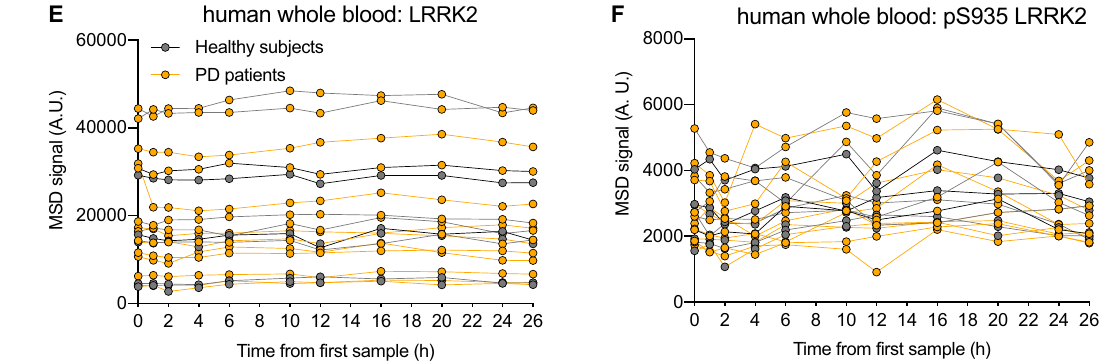
Figure 4. Development of LRRK2 and pT73 Rab10 assays for human blood-based biomarker analysis. ( A ) pS935 LRRK2 and total LRRK2 levels were measured with serial dilutions of lysates from human PBMCs. Each run denotes an independent experiment with a pooled sample from 4 to 5 donors. ( B ) pT73 Rab10 and total Rab10 levels were measured with serial dilutions of lysates from human PBMCs. ( C ) Inhibition of LRRK2 kinase activity decreased pS935 LRRK2 and pT73 Rab10 levels in a dose-dependent manner in PBMCs with ex vivo treatment of MLi-2 (1 h). PBMCs were from n = 3 donors. The MSD signals were normalized to the response to the lowest concentration of MLi2 (0.003 nM) as 100% within each donor. ( D ) pS935 and total LRRK2 levels measured with serial dilutions of samples of human whole blood. Each run denotes an independent experiment with a pooled sample from 4 to 5 donors. ( E , F ) Whole blood specimens from 12 Parkinson’s Disease patients (3 Female, 9 Male) and 6 Non-Parkinson’s controls (2 Female, 4 Male) from the 24-h Biofluid Sampling Study (provided by the Michael J. Fox Foundation) were analyzed. Biospecimens were donated by each subject at 11 time points over 26 h. ( E ) Total LRRK2 levels in whole blood from healthy subjects and PD patients were stable within subjects over the course of 24 h (average coefficient of variation (CV) = 7%; average maximum to minimum value within- subject fold change of 1.25), while displaying high variability between subjects (66% CV, 11.6-fold difference in maximum to minimum value). ( F ) pS935 LRRK2 levels measured in human whole blood samples varied to a greater extent than total LRRK2 within subjects (average CV = 17%, average within-subject maximum to minimum value fold change of 1.76), with less variability between subjects than that observed for total LRRK2 (36% CV, 3.8-fold difference in maximum to minimum